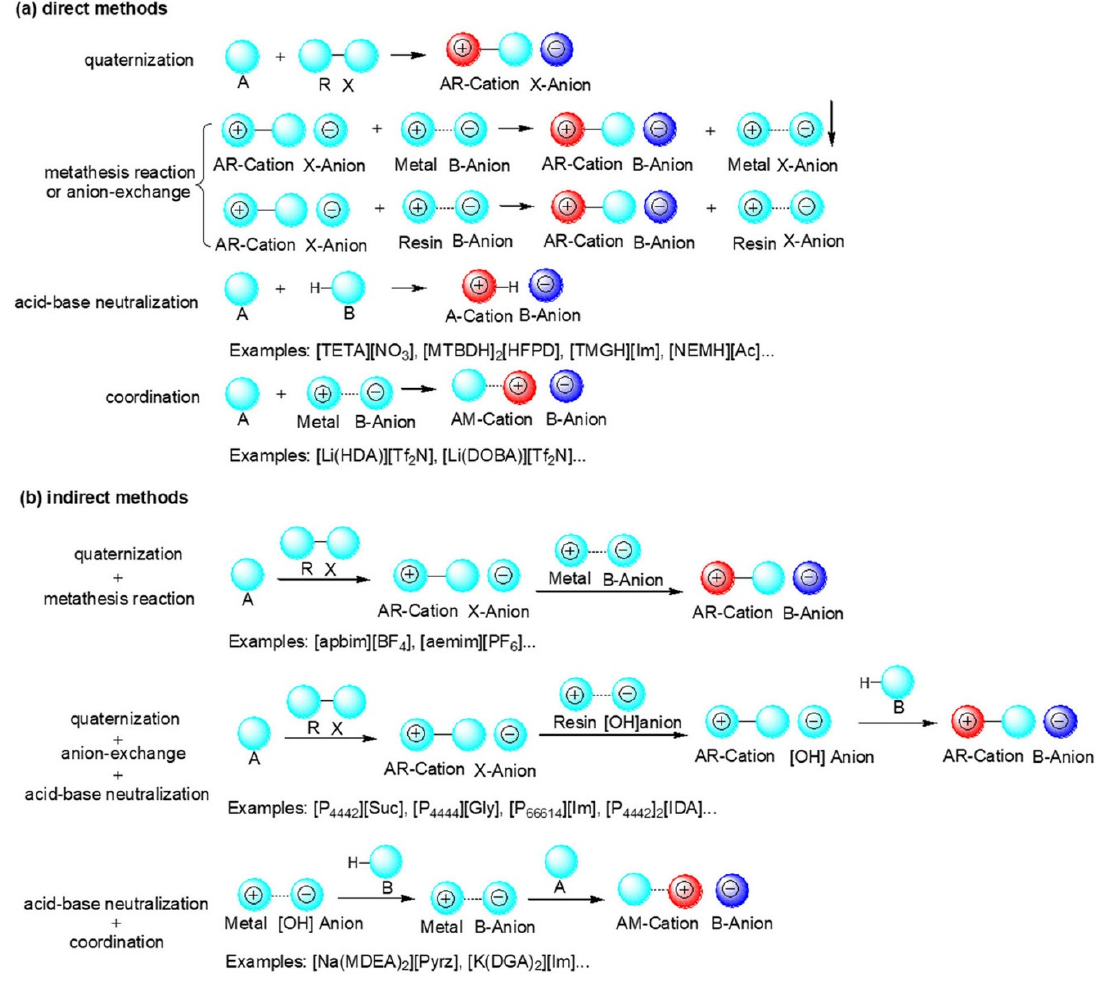
Figure 3. Typical ( a ) direct methods and ( b ) indirect methods for synthesis of functionalized ILs for CO 2 capture.